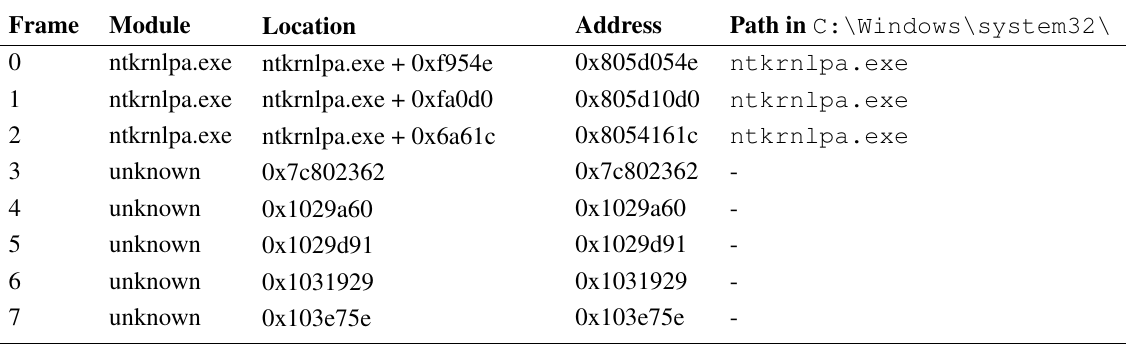
Table 6. Unknown function calls in the stack trace of services.exe .